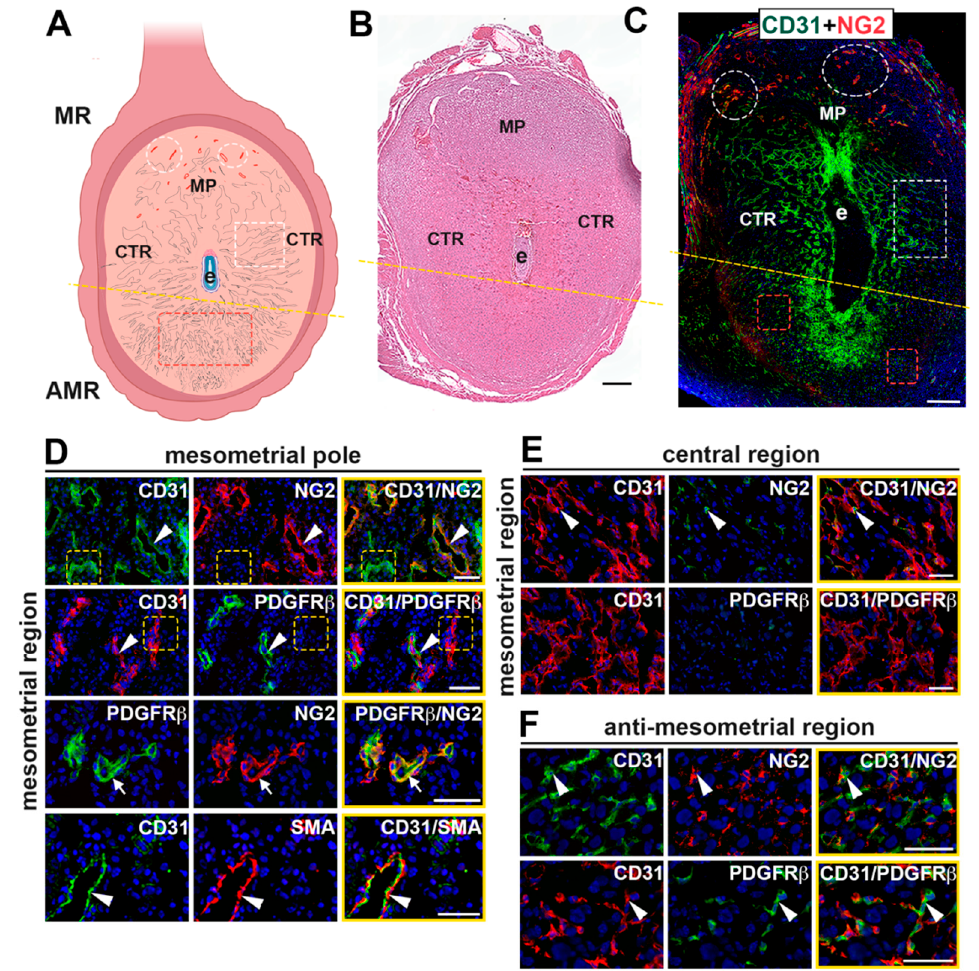
Figure 1. Characterization of the E7.5 uterine vasculature in wildtype mice. ( A ) Schematic representation of an E7.5 implantation site (created with BioRender.com). The implantation site is divided (represented by the dashed line) into two regions, the anti-mesometrial region (AMR) and the mesometrial region (MR), which is further divided into the mesometrial pole (MP) and central